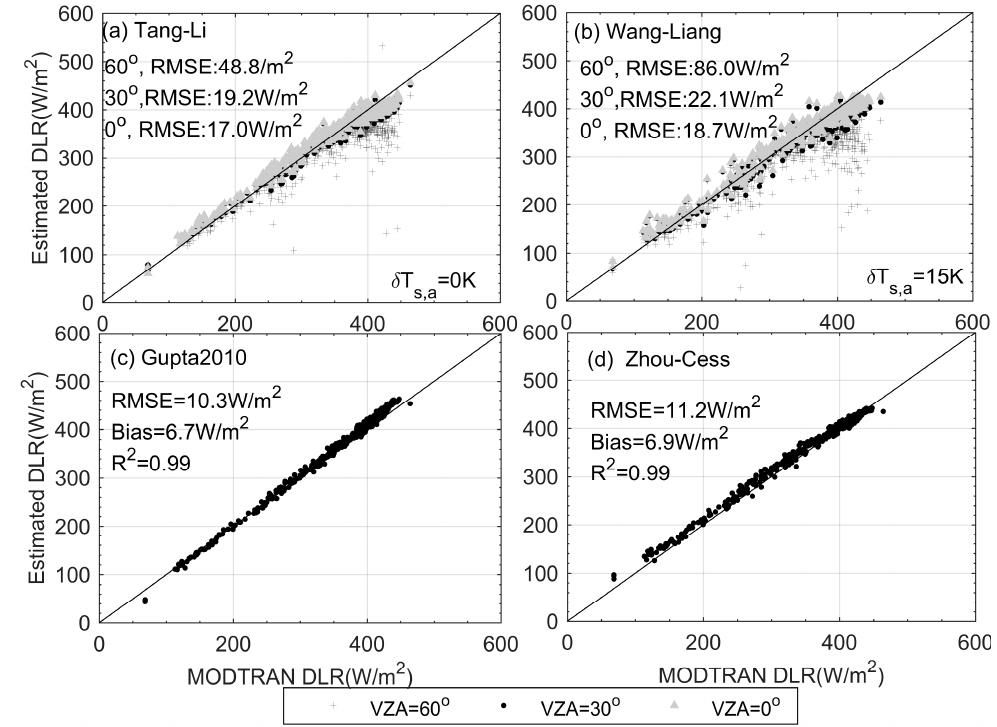
Figure 7. Comparison of the clear-sky flux calculated from DLR algorithms with those from MODTRAN simulation based on the testing dataset. Figures ( a ) to ( d ) represent Tang-Liang, Wang-Li, Gupta2010, and Zhou-Cess algorithms, respectively, and δ T s,a is 0 K and 10 K in Figures ( a ) and ( b ).